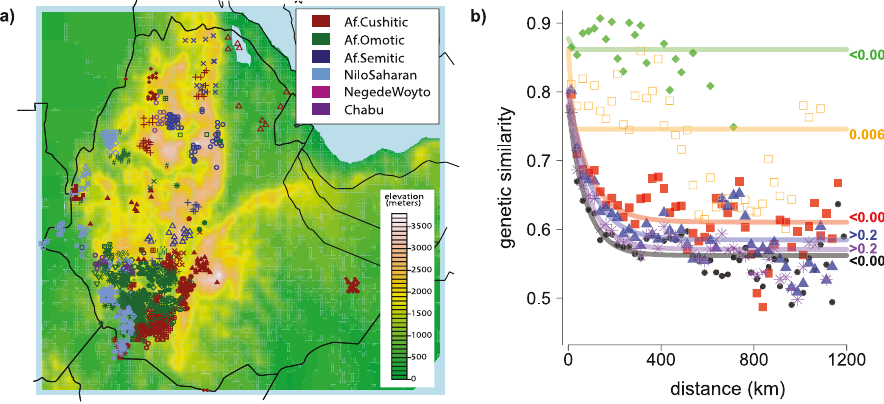
Fig. 1 Genetic similarity decays with spatial distance among Ethiopians and correlates with shared reported ethnicity and language. a Locations of sampled Ethiopians based on birthplace (in some cases slightly moved due to overlap), with landscape colours showing elevation and coloured symbols depicting the language category (plus unclassi fi ed languages Negede Woyto, Chabu) of each individual ’ s ethnic identity. The legend for the symbols is provided in Supplementary Fig. 1. b Fitted model for genetic similarity (1-TVD; under the “ Ethiopia-internal ” analysis) between pairs of individuals versus geographic distance, with points depicting the average genetic similarity within 25 km bins, for all individuals (black; dots) or restricting to individuals who report the same group label (green; diamonds), same fi rst language (orange; open squares), same second language (blue; triangles), same religious af fi liation (purple; asterisks), or whose reported ethnicities are from the same language group (red; closed squares). Labels at right give permutation-based p values when testing the null hypothesis of no increase in genetic similarity among individuals sharing the given trait (see “ Methods ”